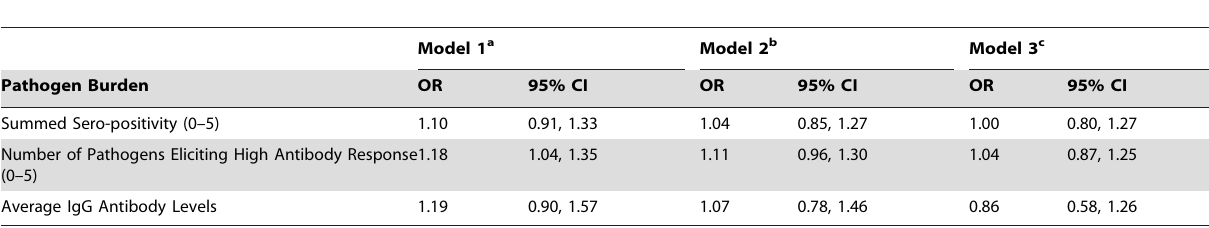
Table 4. Pathogen Burden Operationalized Three Different Ways and Incident Stroke, SALSA (n=1621), California,